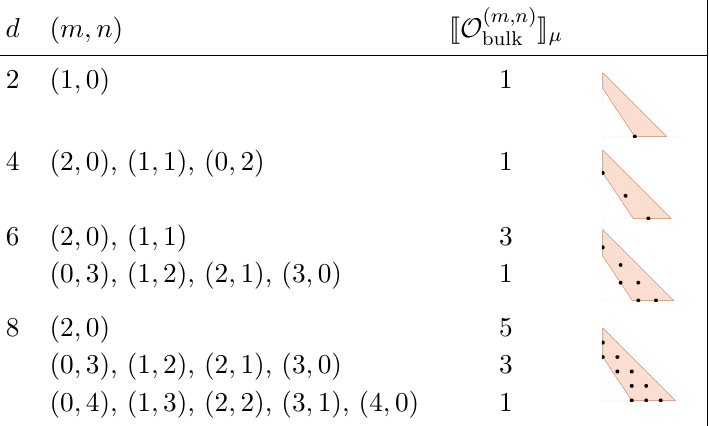
Figure 1 . Divergent bulk operators O ( m,n ) . The operators corresponding to lattice points between bulk the lines 2 m +2 n = d +2 and 3 m +2 n = d +2 have a simple pole and need to be regulated (shaded 2 region). All the operators on a line m + n = const. have the same Q -scaling (dashed lines). The operator O ( ¯ m, 0) has the highest Q -scaling. bulk